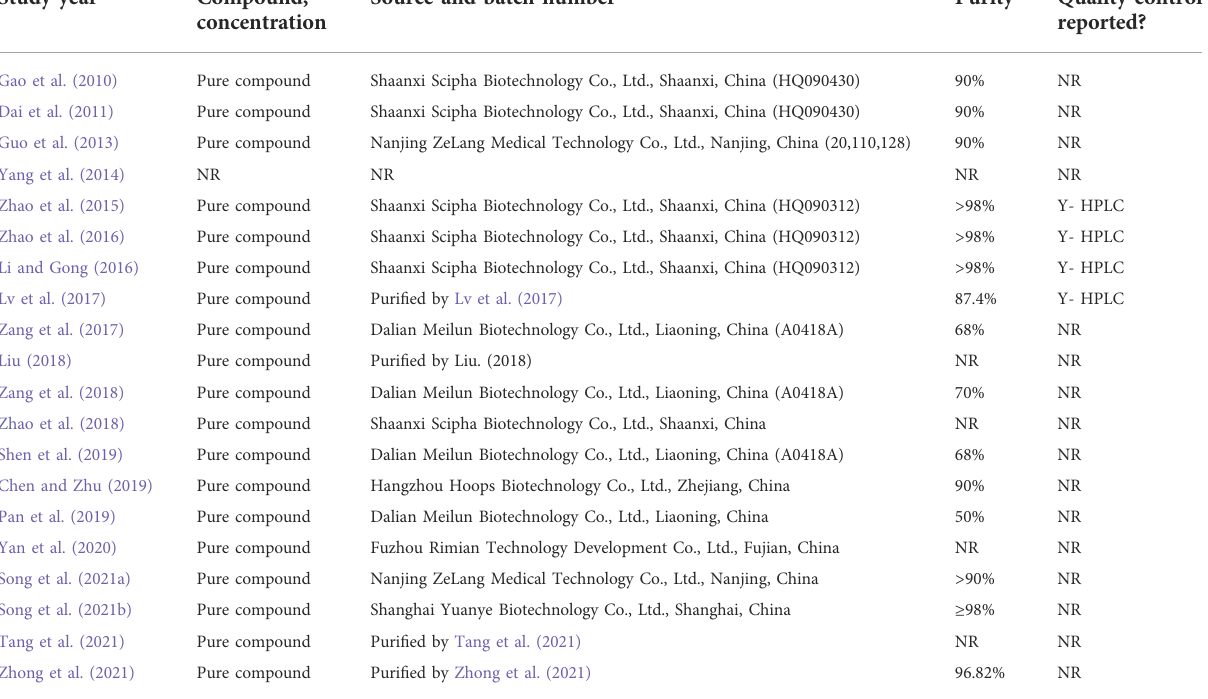
TABLE 2 A summary table describing the